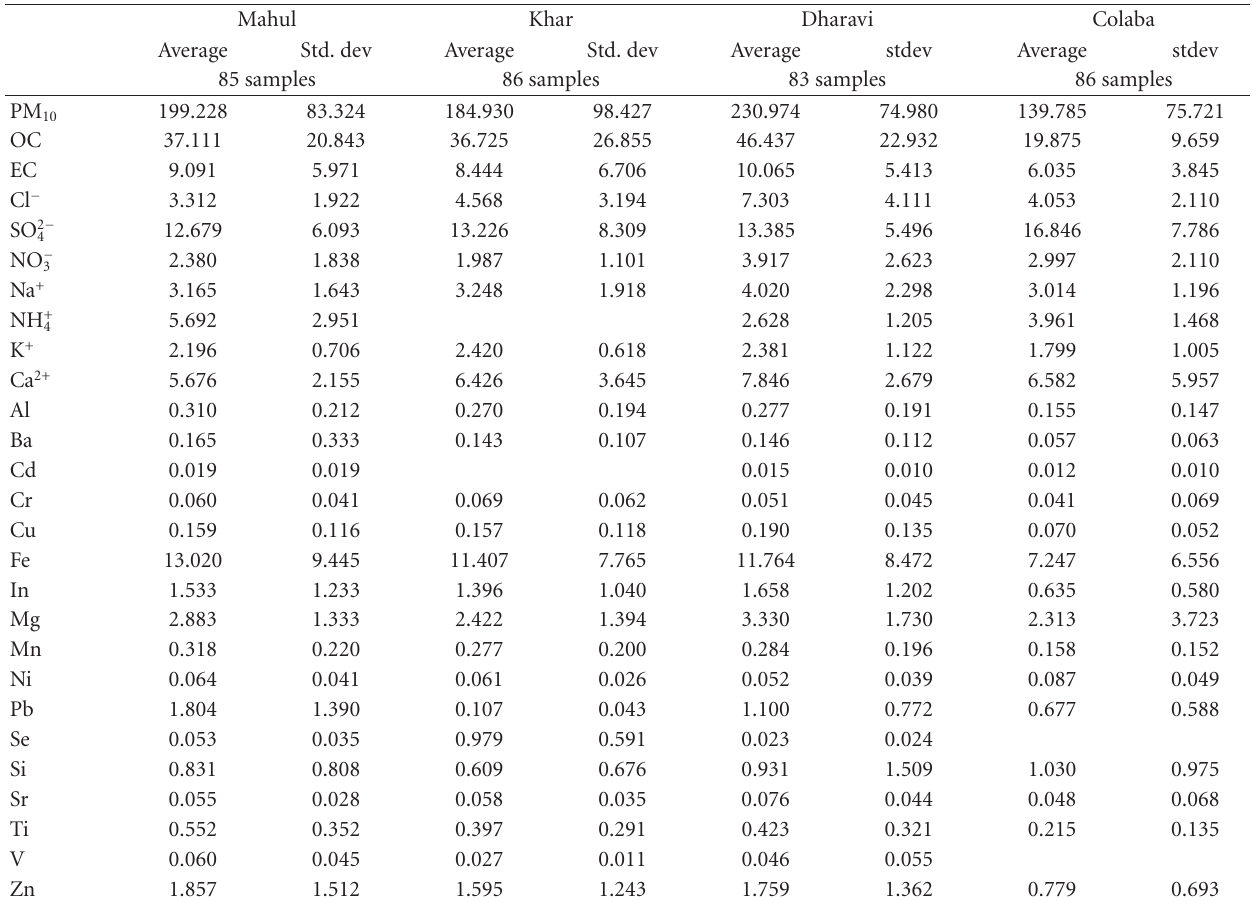
Table 1: Mean and standard deviations (elemental concentration in μ g m − 3 ) of species of four sites of